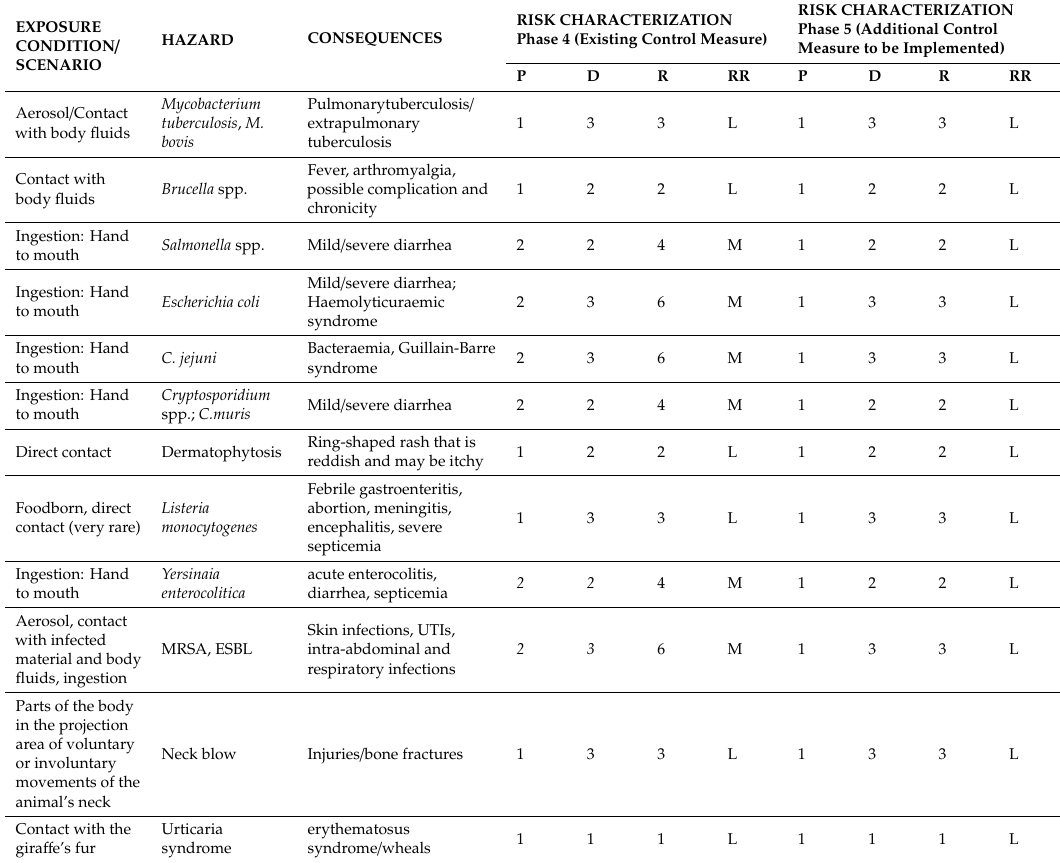
Table 3. Values of risk characterizations for existing control measure and additional control measure to be